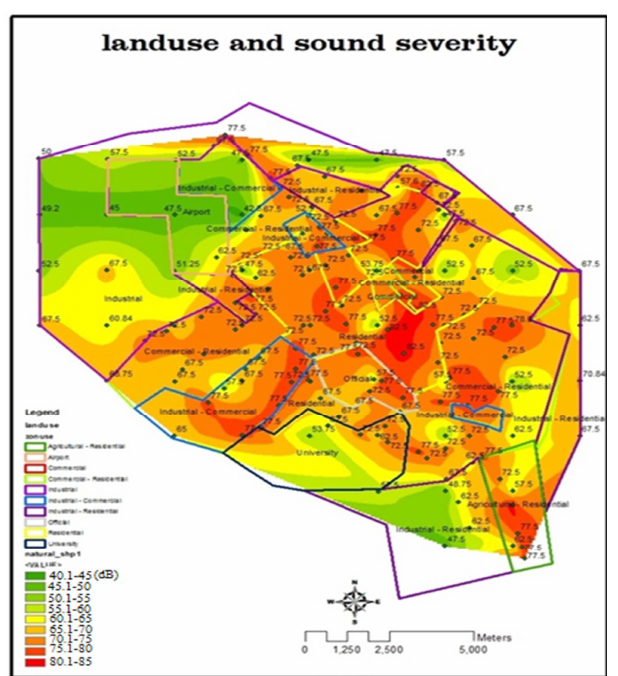
Figure 5. Comparison of the landuse and the sound map of Yazd